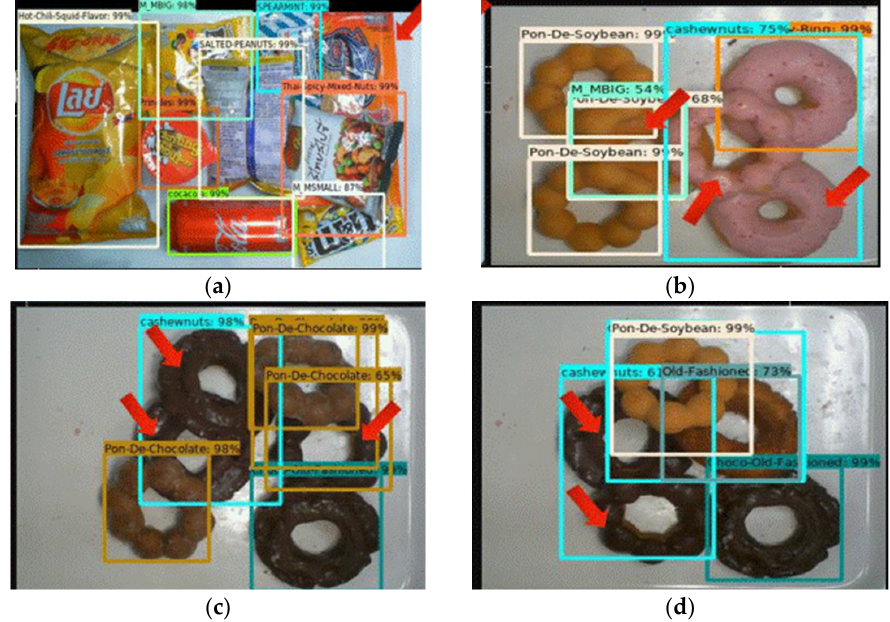
Figure 2. Issues for current object detection systems: ( a ) overlapping, ( b ) indistinguishable color, ( c ) inaccurate detection, and ( d ) indistinguishable color.